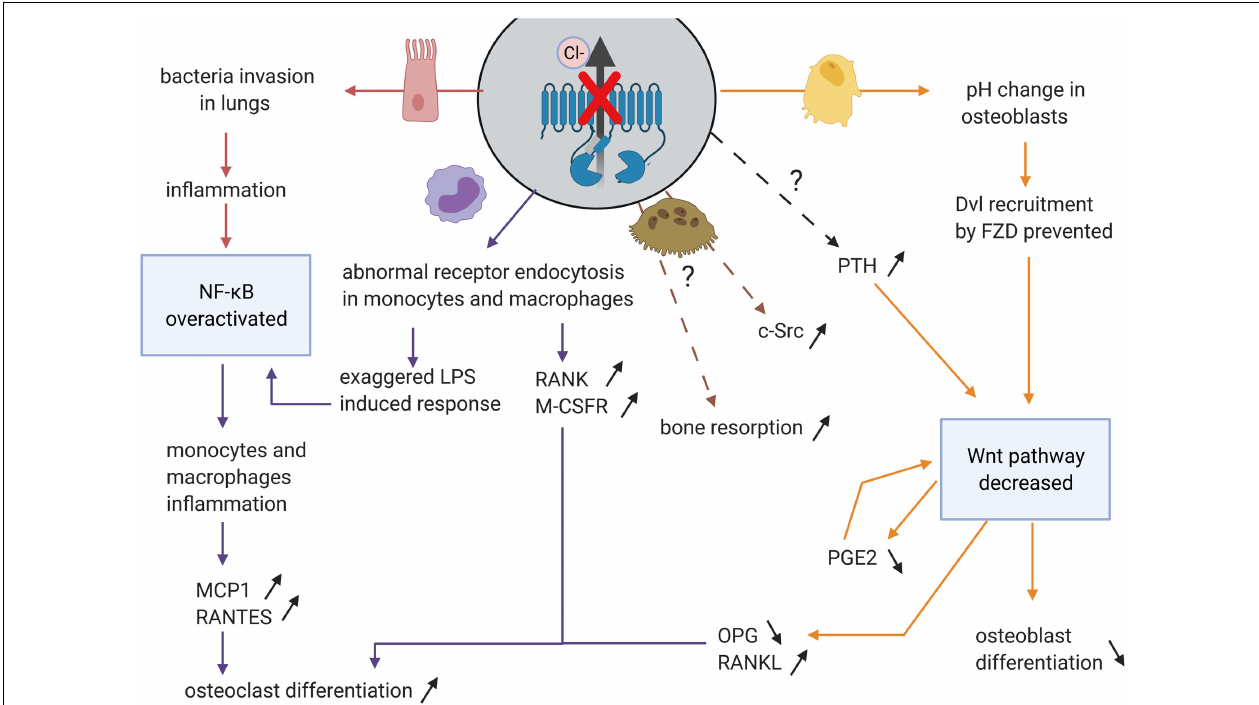
FIGURE 5 | Impact on disruption of chloride channel function of CFTR in the different organs and the consequences for osteoblasts and osteoclasts differentiation and activity. CFTR channel function defect impacts airway epithelial cells (in pink), monocytes and macrophages (in purple), possibly directly osteoclasts (in brown), and osteoblasts (in yellow). In these cells, some pathways (in blue) are disturbed leading to increased osteoclast differentiation and bone resorption and decreased osteoblast differentiation and bone